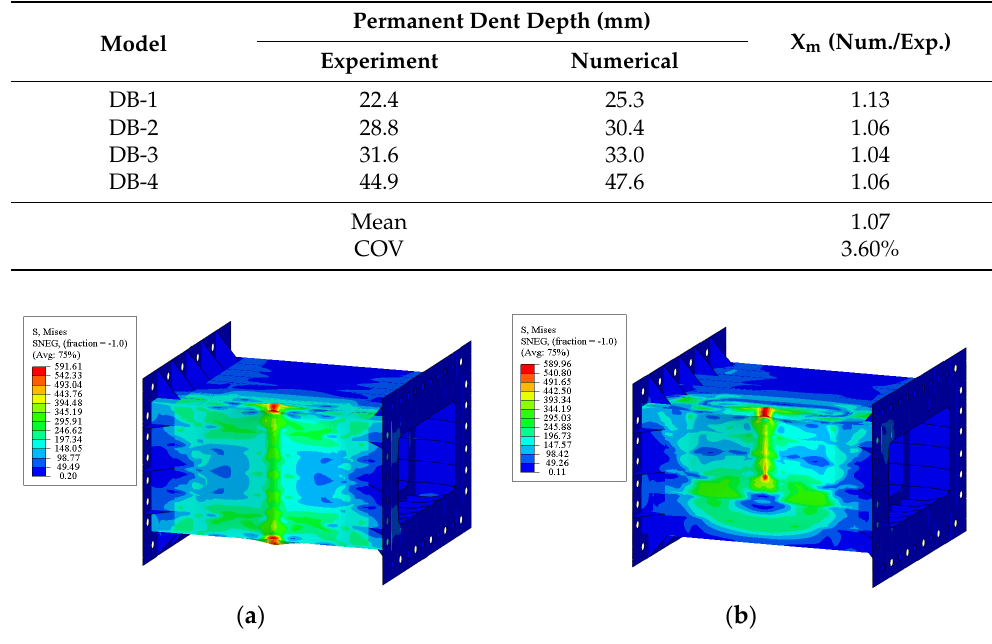
Figure 22. Denting-damaged models after the side collision: ( a ) DB-2; ( b ) DB-4. Table 6. Comparison of the numerical predictions with the experiment results: Denting damage. Model